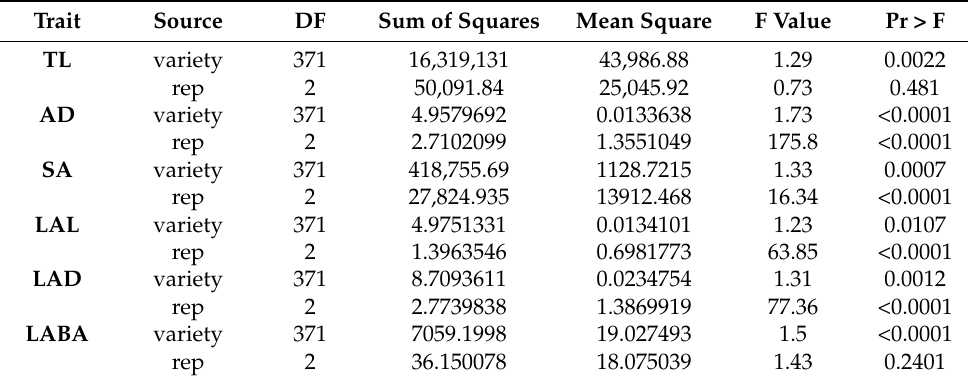
Table 1. Analysis of variance (ANOVA) results from root morphological traits.